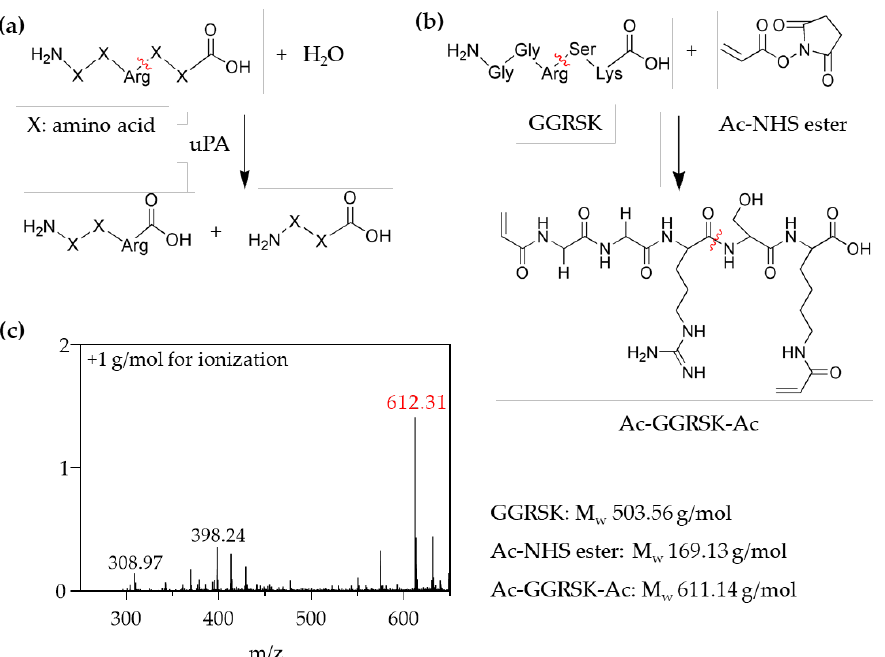
Figure 4. Synthesis of Ac–GGRSK–Ac to be used as the biodegradable crosslinker. ( a ) uPA cleaves the C -terminus of Arg in the peptide sequence. ( b ) The N -terminus of GGRSK and the primary amine of the lysine sidechain react with Ac–NHS ester to create Ac–GGRSK–Ac. ( c ) A mass spectrum of Ac–GGRSK–Ac after purification.